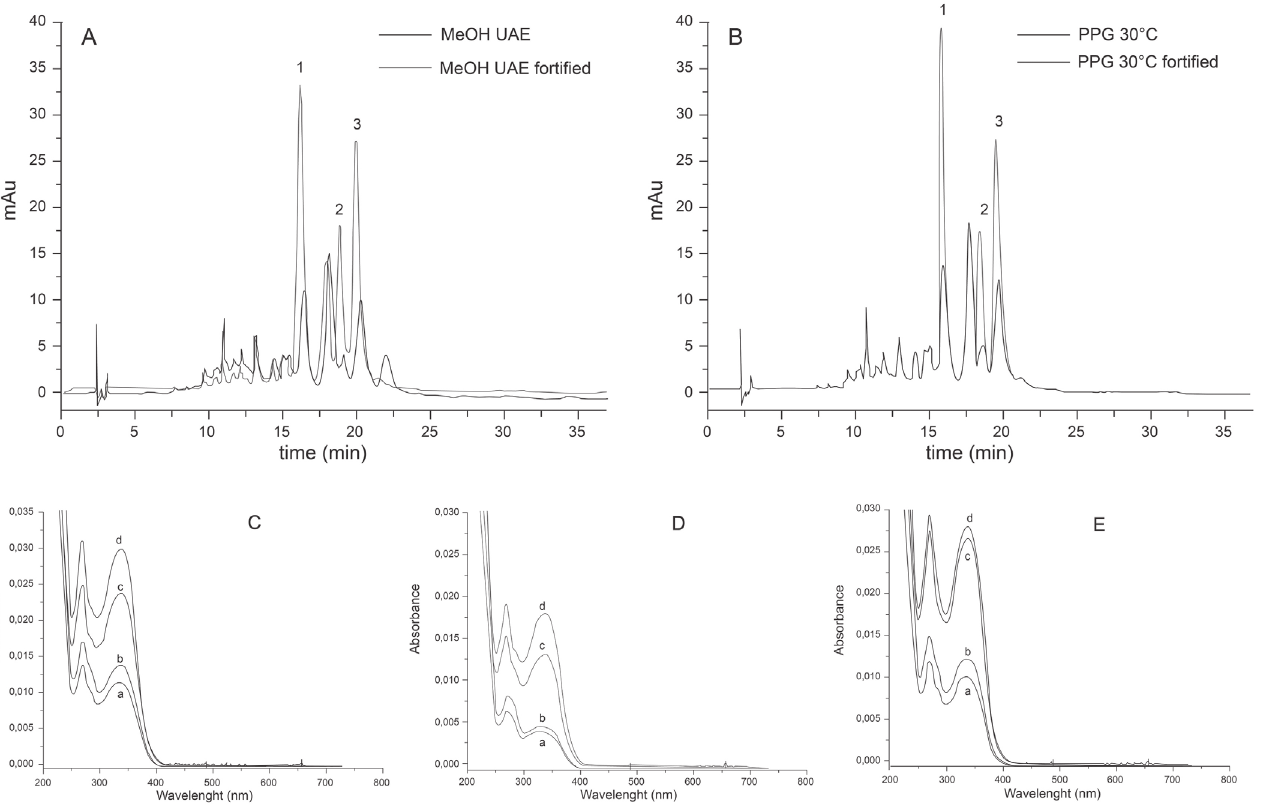
FIGURE 5 - Chromatograms identifying the three flavonoids found in P. coccinea (Aubl.) . A) Chromatogram of UAE methanolic extract. B) Chromatogram of the glycolic extract obtained by 72 h 30ºC maceration. 1: 2”-O- β -D-glucopyranosyl-vitexin; 2: vitexin; 3: isovitexin. C) DAD spectral data of peak 1. D) DAD spectral data of peak 2. E) DAD spectral data of peak 3. a: glycolic extract;